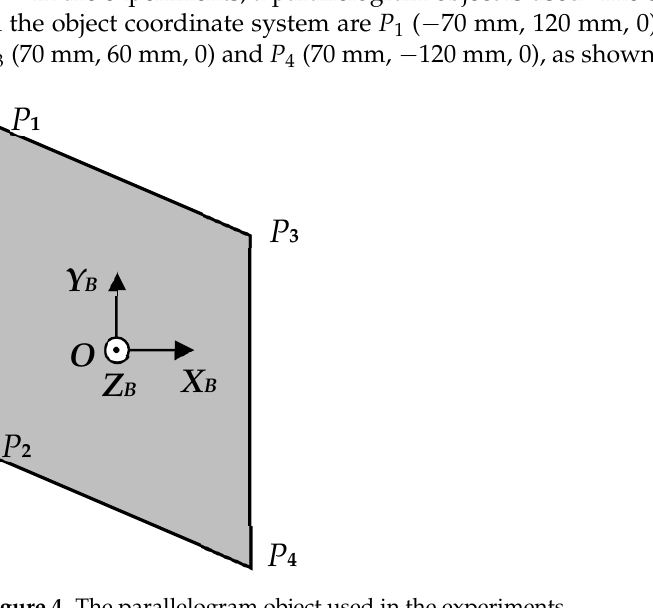
Figure 4. The parallelogram object used in the experiments. A camera with known intrinsic parameters is used to capture images of the object. The proposed method is used to estimate the parallelogram object’s pose parameters relative to the camera and the coordinates of the four vertices. As a comparison, a traditional iterative algorithm is used to estimate the object’s pose parameters. The “iterative algorithm” is actually the bundle adjustment method, a kind of iterative correction and optimization algorithm from initial values, which is famous in photogrammetry and computer vision for its performance of high accuracy. For the traditional method, the parallelogram vertices’ coordinates are taken as known, only the parallelogram’s pose parameters are to be solved. One of the experimental images is shown in Figure 5, where the white crosses show the extracting positions of the parallelogram